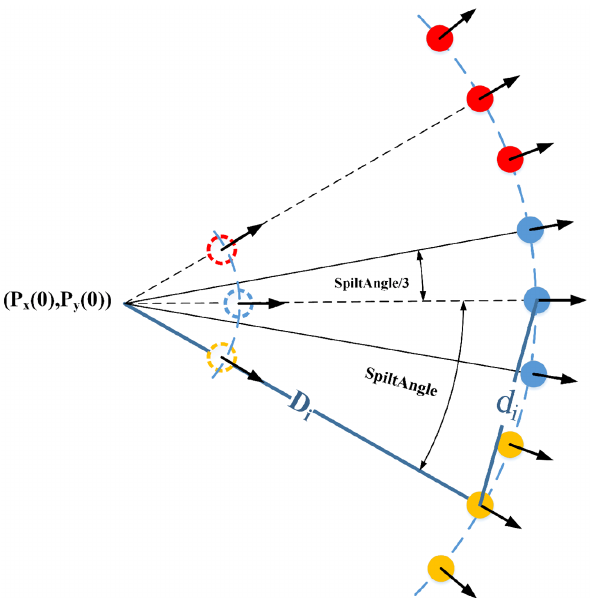
Fig 6. The change before and after particle splitting occurs and the computation of the distance d i between neighboring